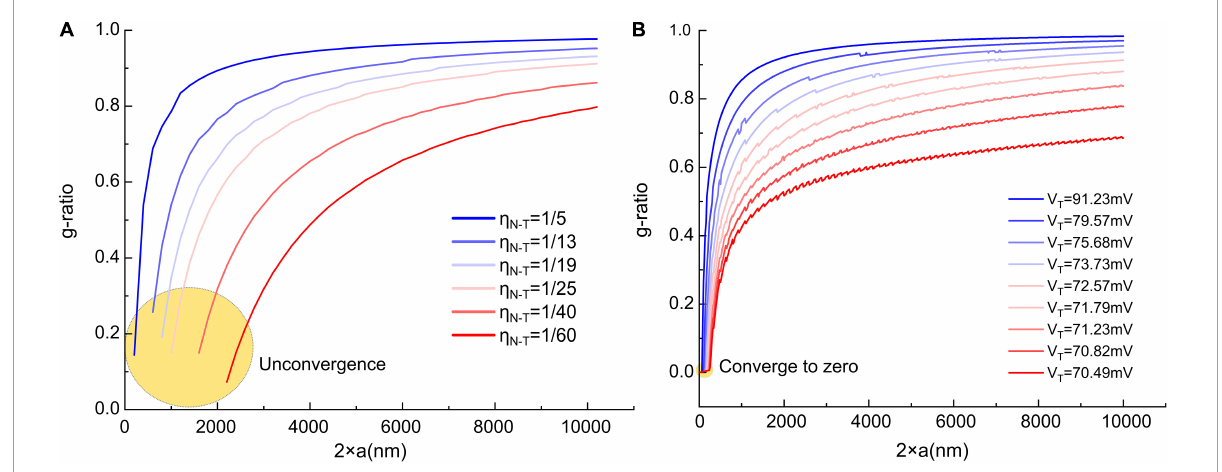
FIGURE12 The comparison of the g-ratio curves before and after the correction. (A) The g-ratio curves before the correction, these curves are not converged to zero point; (B) the g-ratio curves after the correction, all curves are converged to zero point.